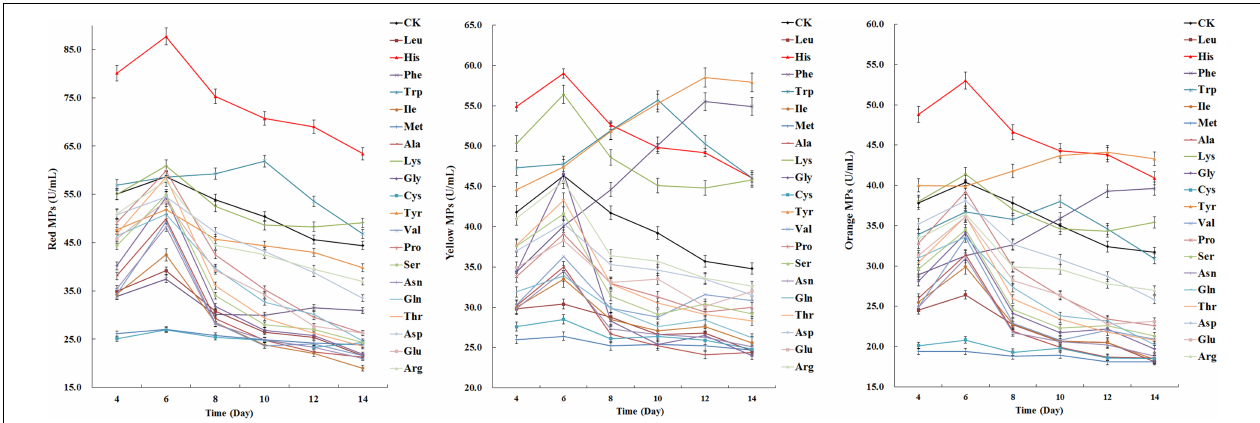
FIGURE 1 | Effects of 20 amino acids on Monascus pigments (MPs) production in Monascus purpureus RP2 fermentation. CK, M. purpureus RP2 fermentation without the addition of amino acid; Leu, M. purpureus RP2 fermentation with the addition of leucine (LEU); His, M. purpureus RP2 fermentation with the addition of histidine (HIS); Phe, M. purpureus RP2 fermentation with the addition of phenylalanine (PHE); Trp, M. purpureus RP2 fermentation with the addition of tryptophan (TRP); Ile, M. purpureus RP2 fermentation with the addition of isoleucine (ILE); Met, M. purpureus RP2 fermentation with the addition of methionine (MET); Ala, M. purpureus RP2 fermentation with the addition of alanine (ALA); Lys, M. purpureus RP2 fermentation with the addition of lysine (LYS); Gly, M. purpureus RP2 fermentation with the addition of glycine (GLY); Cys, M. purpureus RP2 fermentation with the addition of cysteine (CYS); Tyr, M. purpureus RP2 fermentation with the addition of tyrosine (TYR); Val, M. purpureus RP2 fermentation with the addition of valine (VAL); Pro, M. purpureus RP2 fermentation with the addition of proline (PRO); Ser, M. purpureus RP2 fermentation with the addition of serine (SER); Asn, M. purpureus RP2 fermentation with the addition of asparagine (ASN); Gln, M. purpureus RP2 fermentation with the addition of glutamine (GLN); Thr, M. purpureus RP2 fermentation with the addition of threonine (THR); Asp, M. purpureus RP2 fermentation with the addition of aspartic acid (ASP); Glu, M. purpureus RP2 fermentation with the addition of glutamic acid (GLU); Arg, M. purpureus RP2 fermentation with the addition of arginine (ARG).